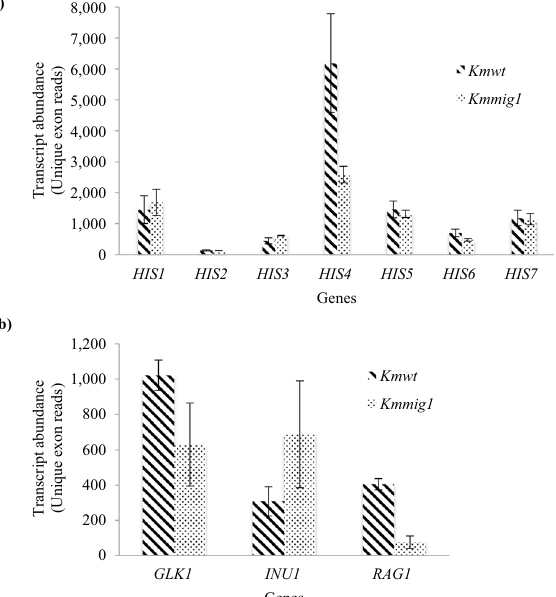
Figure 1. Effects of MIG1 -disrupted mutation on transcription of several genes for histidine biosynthesis and of GLK1 , INU1 and RAG1 in K . marxianus . RNA-Seq analysis was performed as described in Materials and methods. Transcript abundance in the form of unique exon reads of Km WT and Kmmig1 was estimated for several genes for histidine biosynthesis ( a ) and GLK1 for glucokinase, INU1 for inulinase and RAG1 for glucose transporter ( b ) in K . marxianus . Data presented are averages of triplicate independent experiments, and error bars indicate standard deviations.